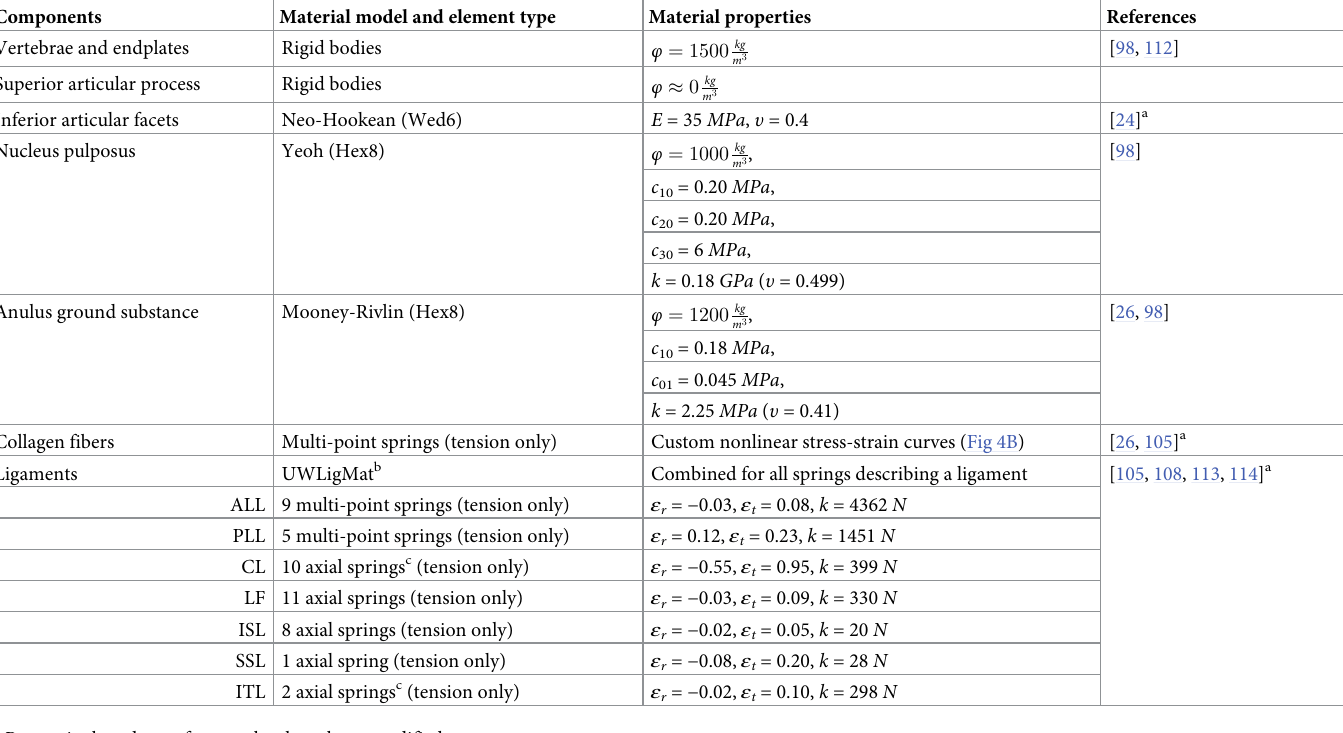
Table 1. Element types and material properties of the components of the final passive hybrid model.